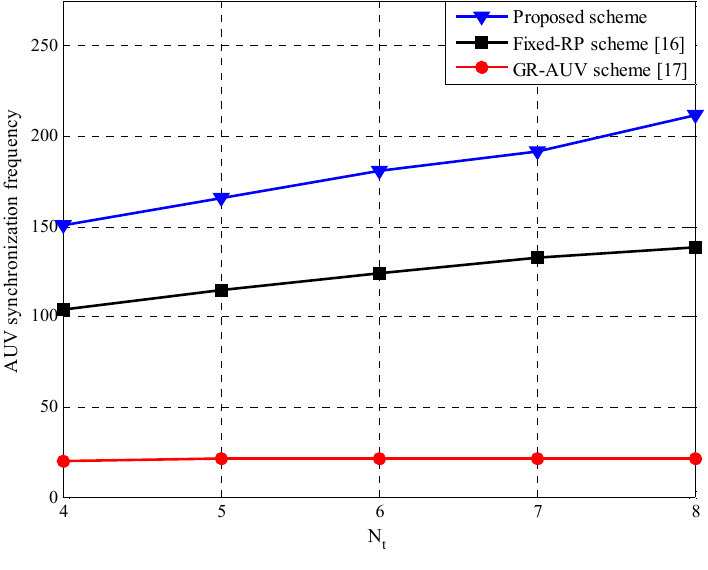
Figure 10. AUV synchronization frequency versus the number of our-points, N t